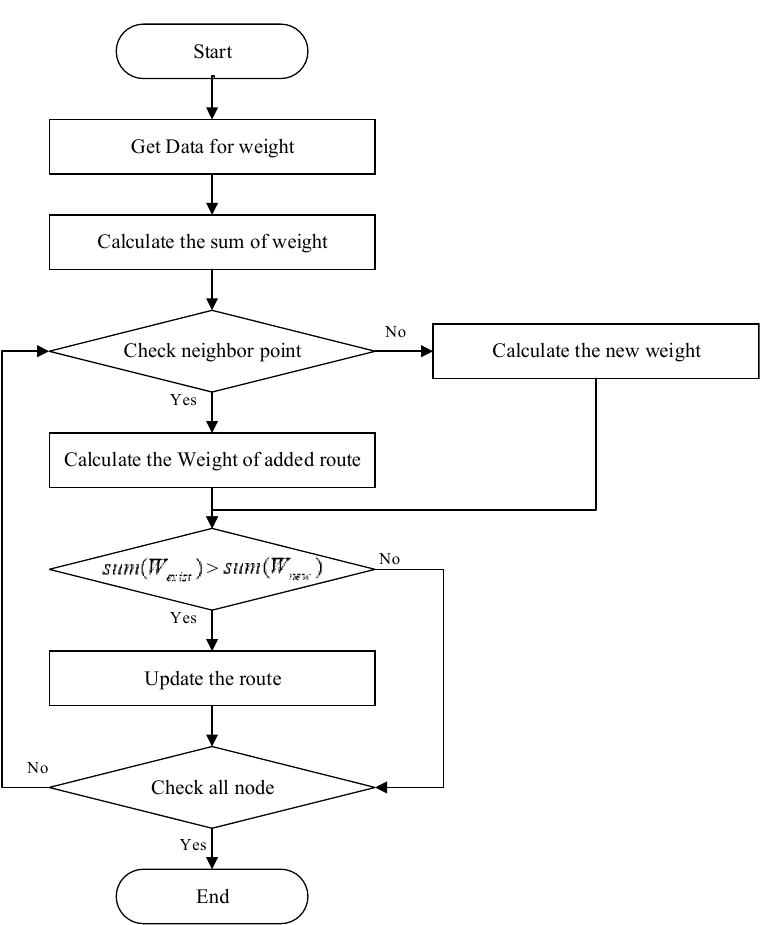
Figure 1. Flowchart of Dijkstra’s algorithm.